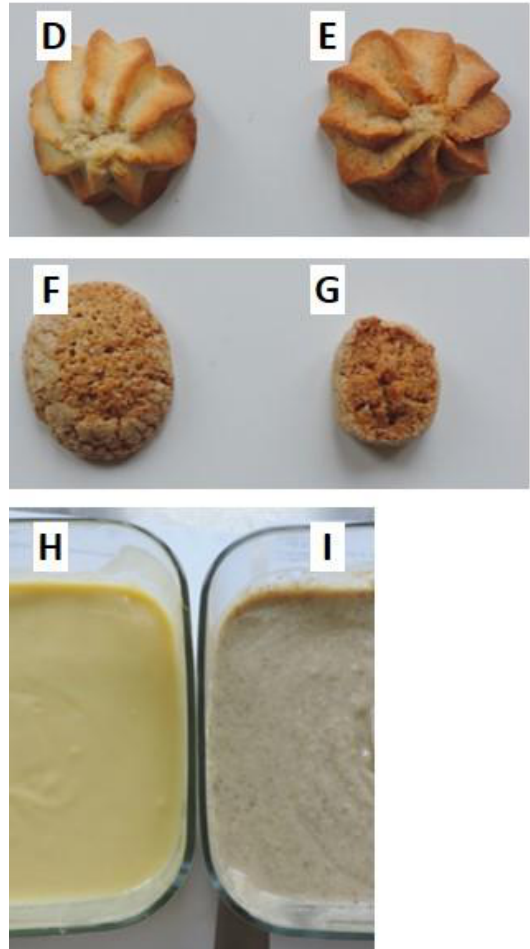
Figure 1. Samples used for the sensorial evaluation. ( A ) Cracker R, ( B ) Cracker 1, ( C ) Cracker 2, ( D ) Biscuit 1R, ( E ) Biscuit 1, ( F ) Biscuit 2R, ( G ) Biscuit 2, ( H ) Cream R, ( I ) Bean Cream. All R samples were reference without common bean flour, while the samples Crackers 1 and 2, Biscuits 1 and 2 and Bean Cream contained 26, 38, 29, 14 and 9% of common bean flour, respectively.